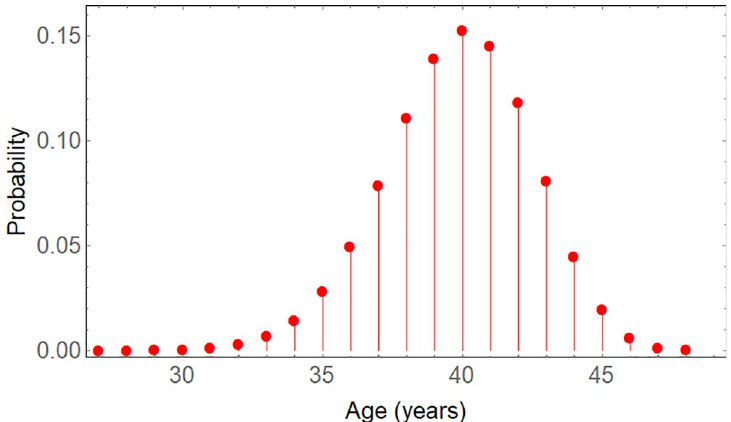
Fig 3. Discrete probability density function of the age of boundary 48, for ages above 26 years. The distribution is limited to the range of 0 to 48 years. The estimated mean (or expected) age is 39.84 years. This is equal to the sum of input probabilities after the base boundary, here 0.83 � 48, as expected from Theorem 1.